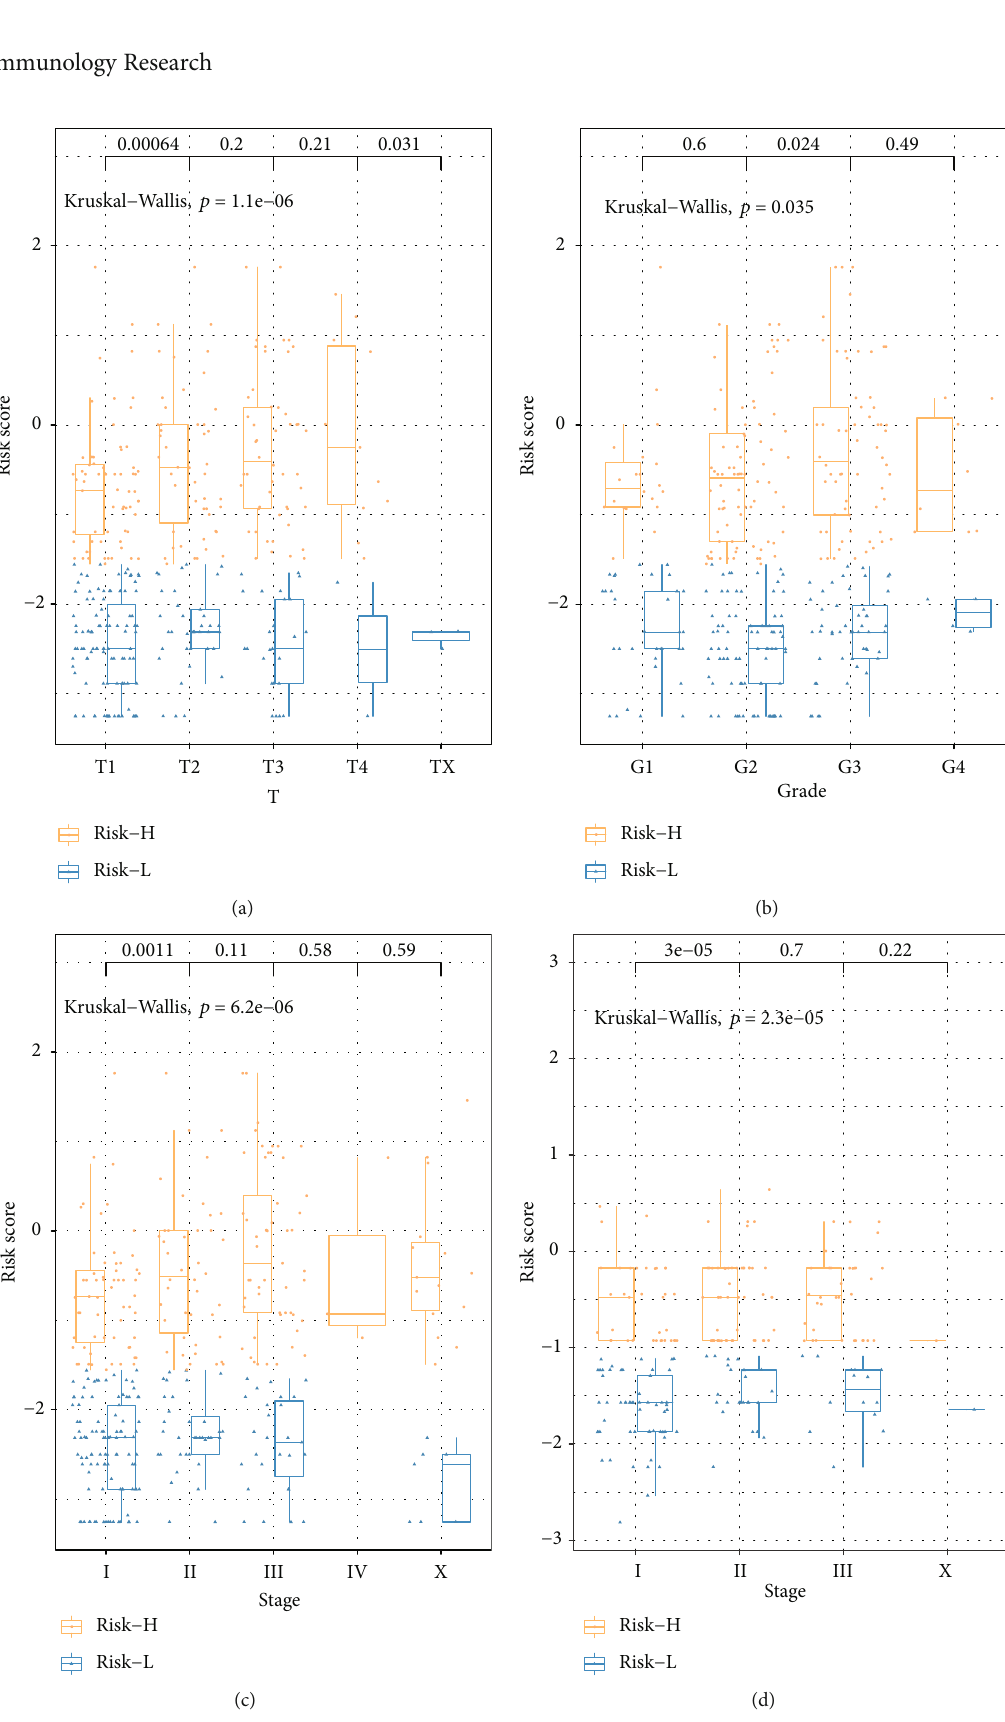
Figure 4: Association between clinical features (T, stage, and grade) and risk score based on the nine-IRGP signature. Distribution of risk scores in (a) T, (b) grade, and (c) stage for TCGA data set. (d) Distribution of risk scores in stage for GSE14520 data